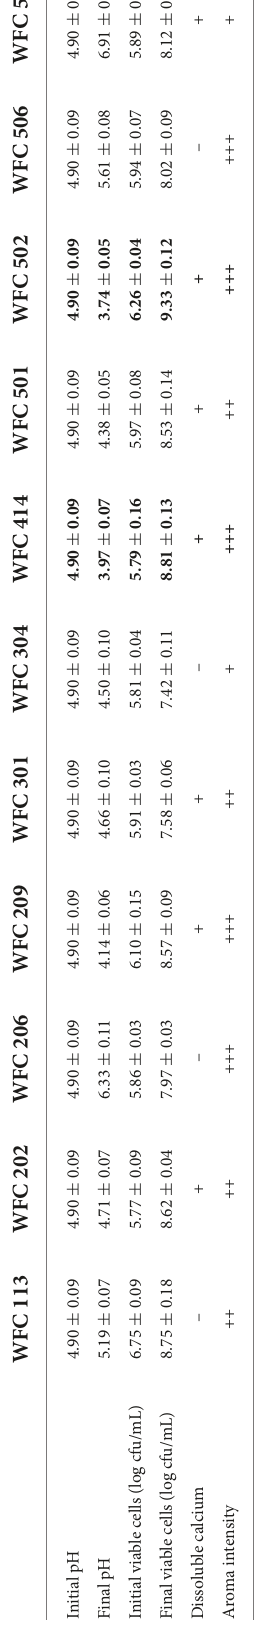
FIGURE1 Sensory profiles of apple juice fermented by different strains.